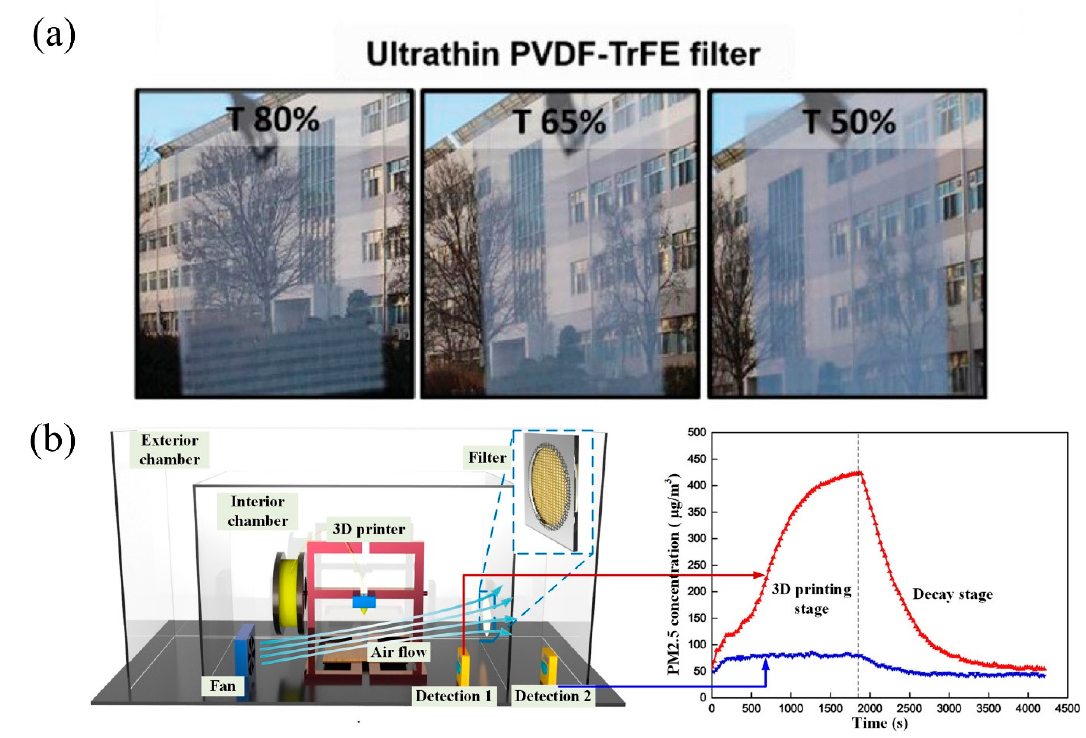
Figure 13. ( a ) Photographs of the PVDF-TrFE nanofiber filters with different light transmittances (T): 80%, 65%, and 50%. Adapted with permission from ref. [98]. Copyright 2019 Wiley-VCH Verlag GmbH & Co. KGaA, Weinheim. ( b ) Schematic of particles filtration experiment during 3D printing. Reprinted with permission from ref. [101]. Copyright 2019 Elsevier B.V.